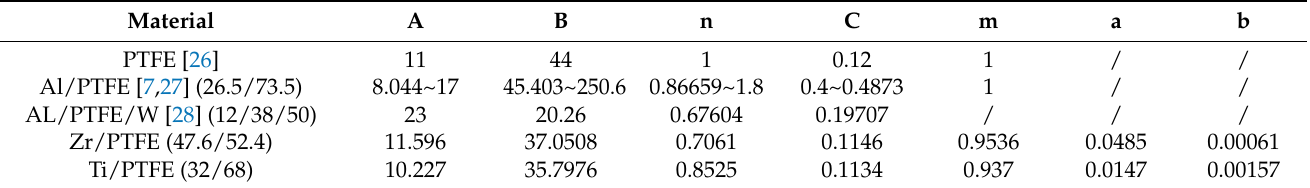
Table 1. Summary of the Johnson–Cook constitutive model parameters for PTFE-based RMs.